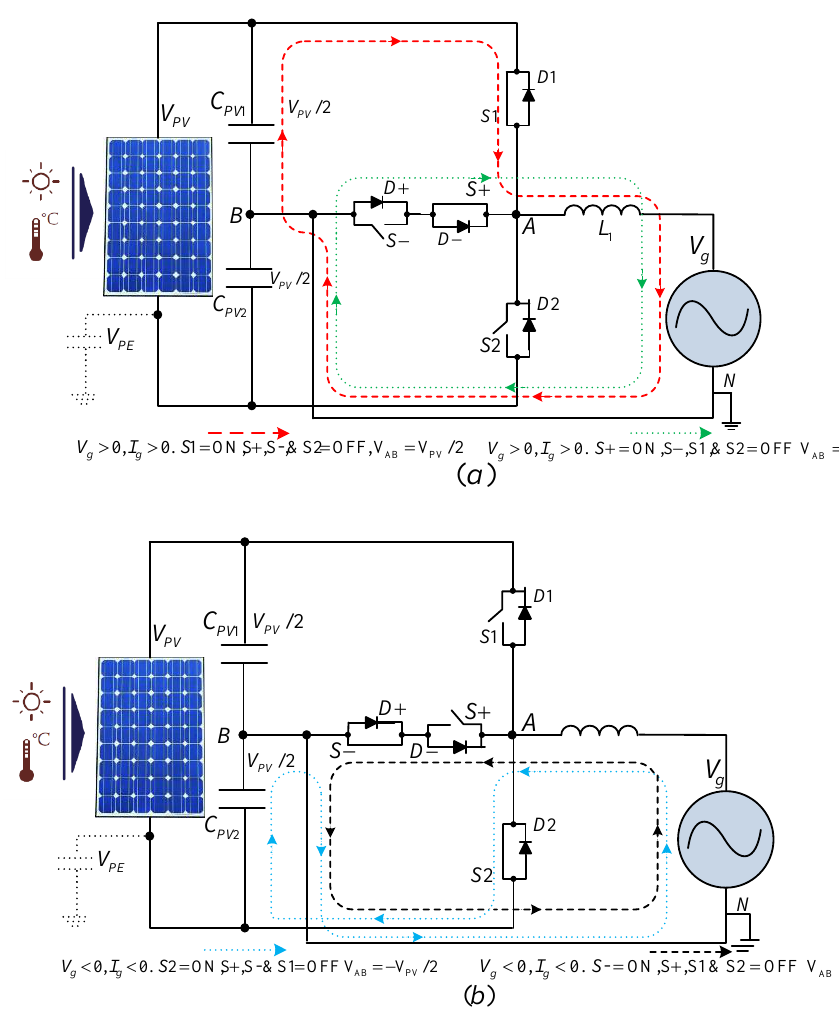
Figure 20. Switching positions of Conergy NPC in case of ( a ) positive cycle and ( b ) negative cycle [29,30].